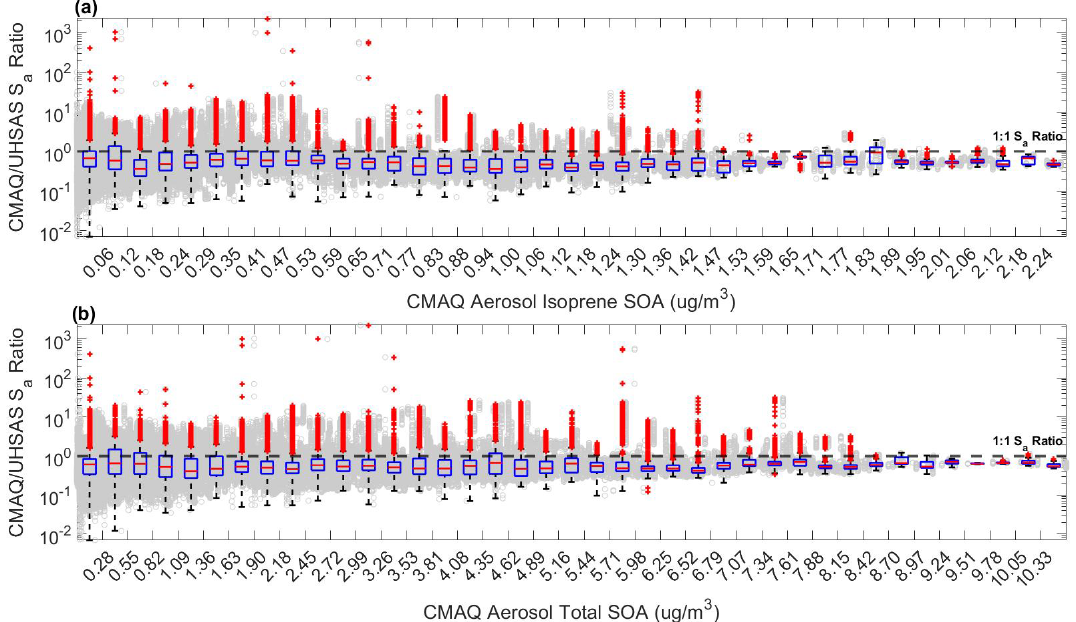
Figure 13. Interquartile ranges in S a , mod /S a , meas as a function of the modeled (CMAQ) (a) isoprene SOA concentration and (b) total SOA